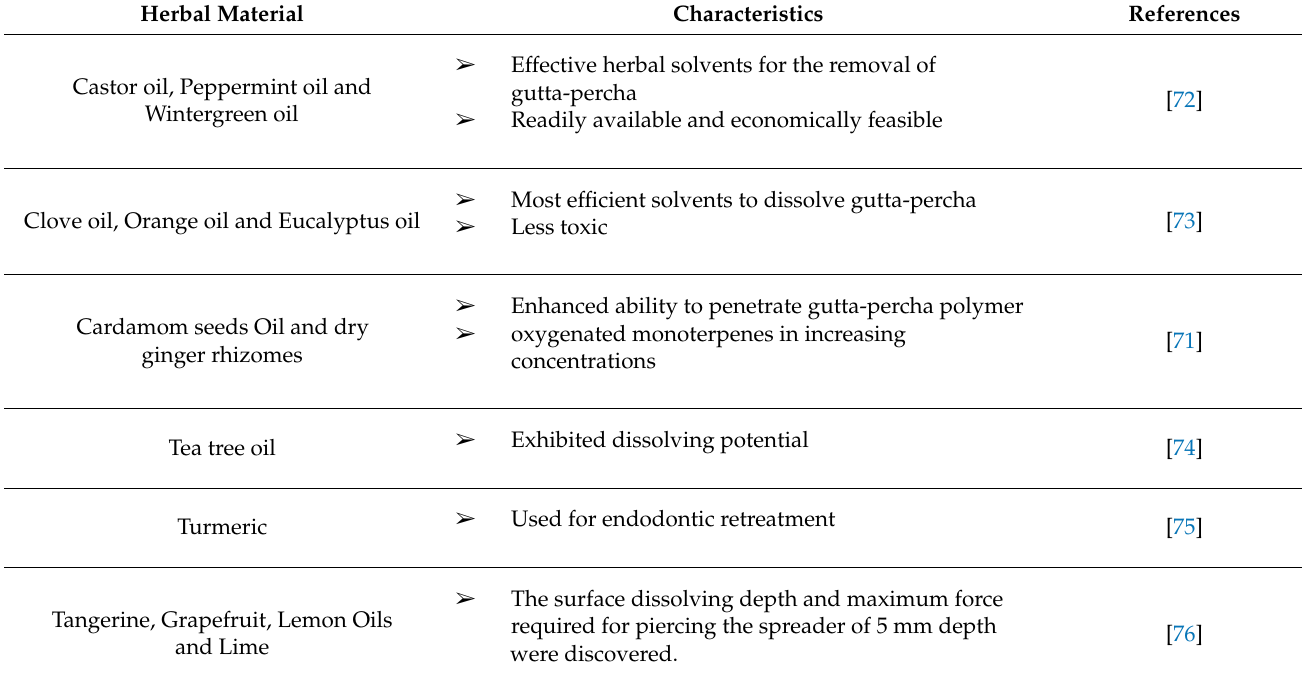
Table 6. Studies related to the use of herbal medication for softening and dissolving of gutta-percha. Herbal Material